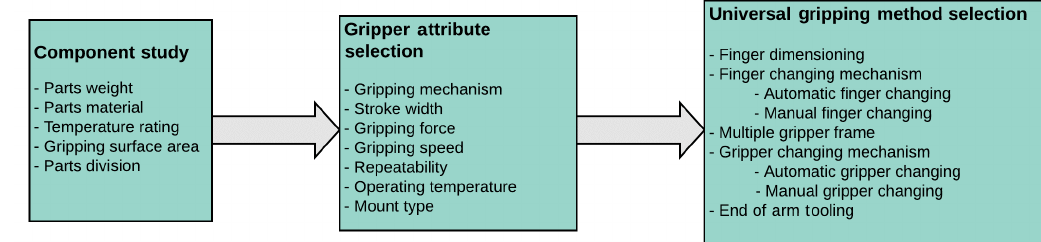
Fig. 6. Process flow for achieving universal